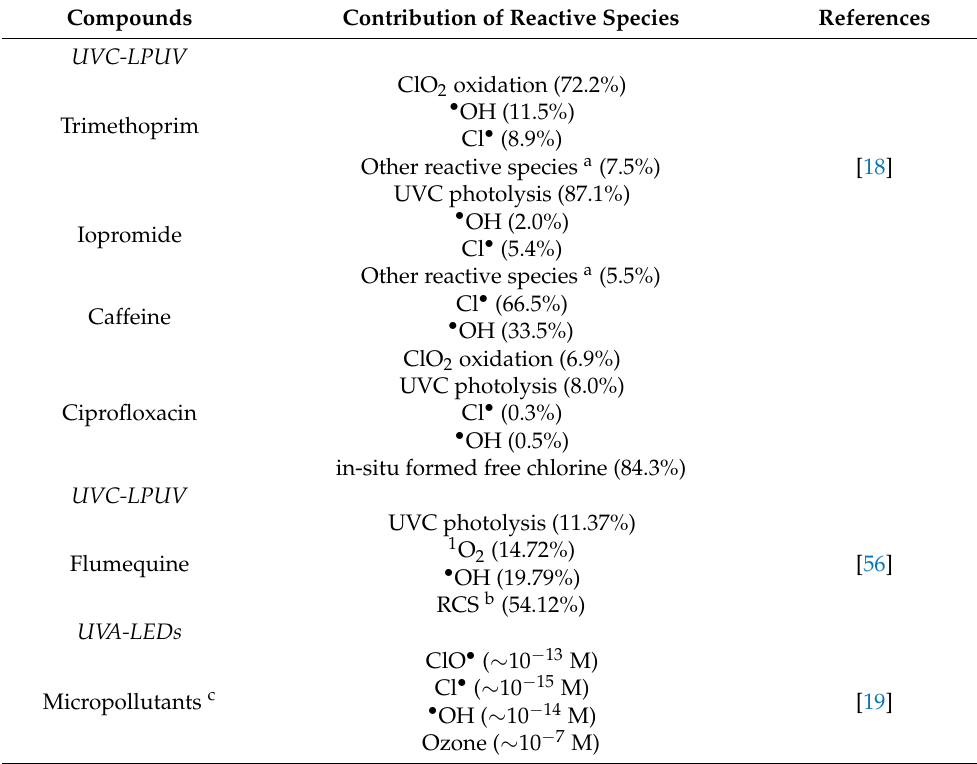
Table 4. The contribution of reactive species for micropollutant abatement in UV/ClO 2 process.